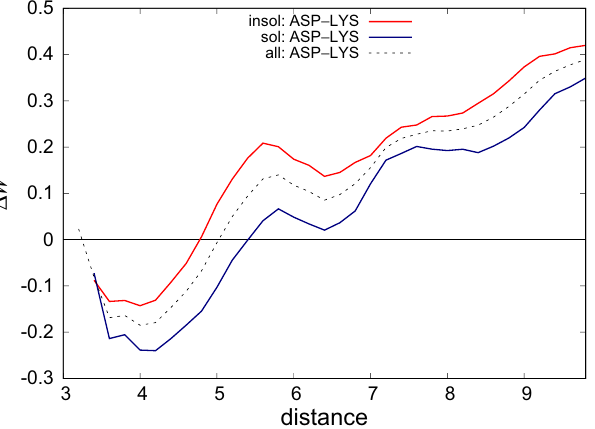
Figure 1. The folding free energy contribution ∆ W d (Asp, Lys, ) of the salt bridge interaction Asp-Lys differs according to whether the potentials are derived from soluble or weakly soluble proteins. The energies are in kcal/mol, the distance d (in Å) is computed between residue side chain centroids, and the residues are separated by at least 8 residues along the chain. Distance bins containing ten occurrences or less are not drawn (see Eq.